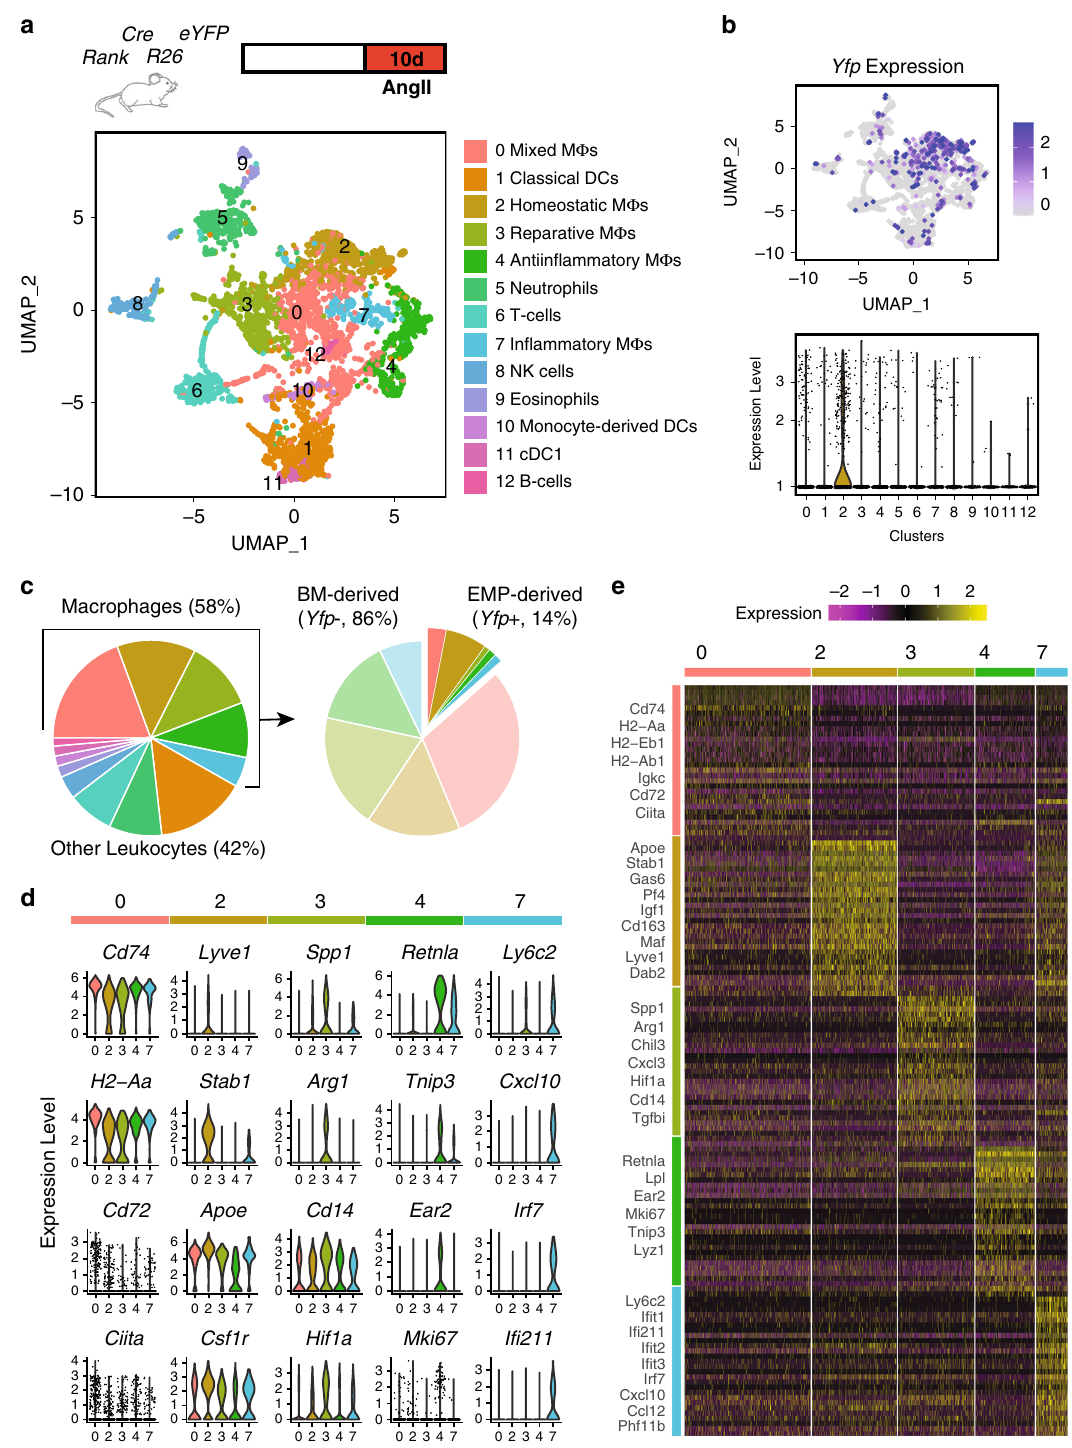
Fig. 6 Transcriptional pro fi ling of macrophages in response to AngII. Single-cell transcriptome analysis reveals the heterogeneity of leukocyte populations in in fl ammation. a UMAP visualization of gene expression in single CD45 + cells in adventitias of Rank Cre Rosa26 eYFP mice treated with AngII for 10 days ( n = 4419 cell from 2 animals), depicting 13 different cell types including 5 distinct macrophage (M ϕ ) subtypes. b Feature (upper panel) and Violin (lower panel) plots showing the expression of Yfp in adventitial leukocytes. Expression of Yfp is mainly identi fi ed in the cluster of homeostatic macrophages (cluster 2). c Proportion of different leukocyte populations in in fl amed aorta (left panel) and fraction of Yfp -expressing cells within adventitial macrophages (right panel). d Violin plots representing signi fi cant ( P value < 0.05) expression of markers of mixed (cluster 0), homeostatic (cluster 2), reparative (cluster 3), anti-in fl ammatory (cluster 4), and in fl ammatory (cluster 7) macrophages. e Heatmap showing top30 marker genes in each macrophage subset. Expression scale is Log2 fold-change of gene expression in the corresponding cluster against all other macrophage clusters. Representative markers of each subtype are